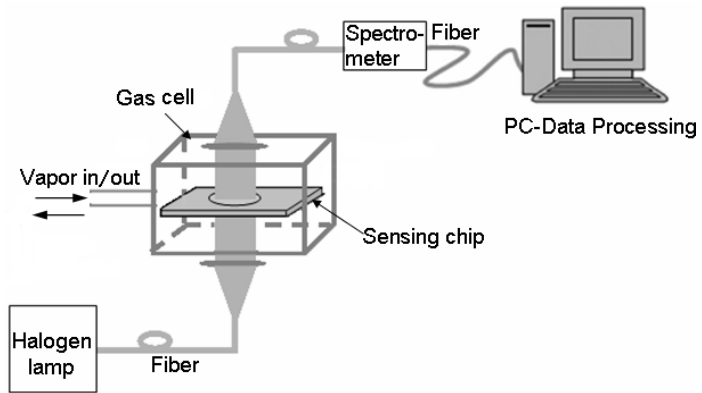
Figure 1. Schematic presentation of experimental